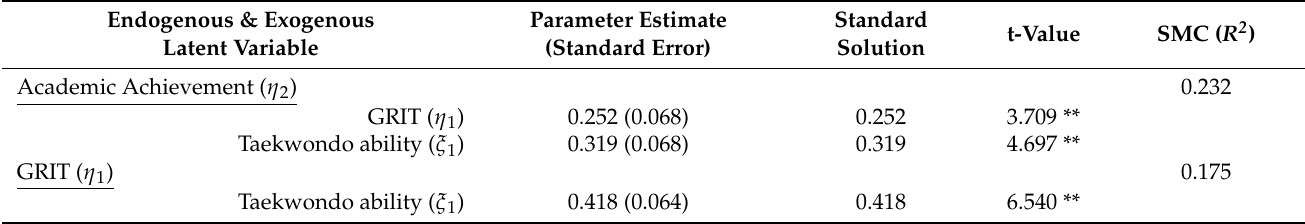
Table 4. Parameter estimates of the research model.